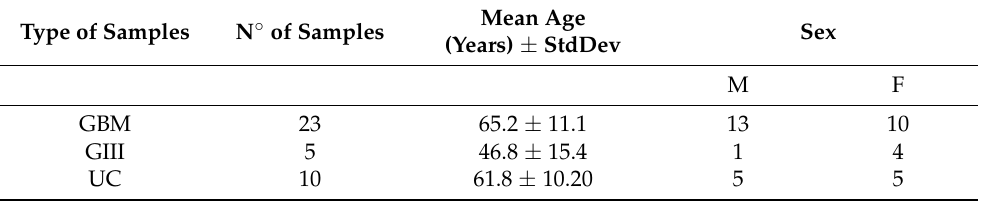
Table 2. Demographic data of the case and control cohorts involved in the study. Type of